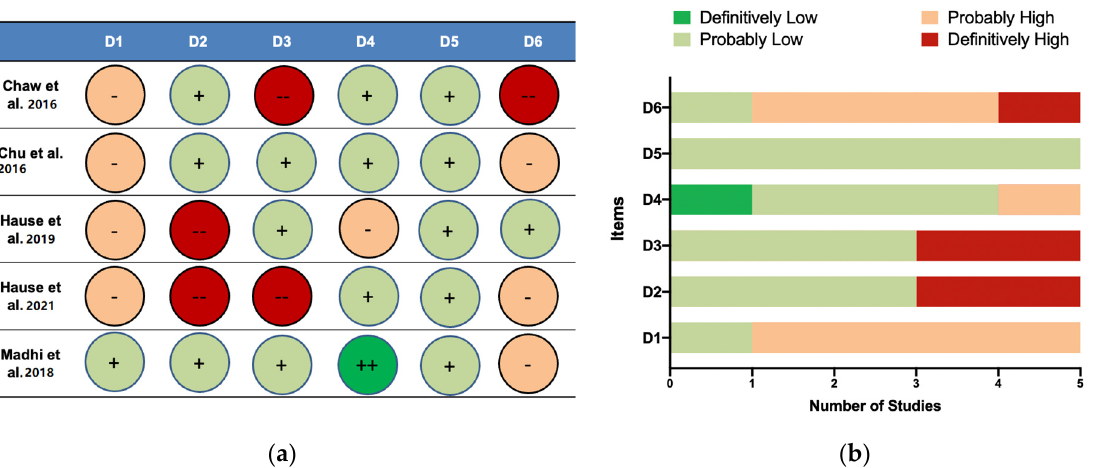
Figure 2. Summary of risk of bias assessment (Note: D1: Possibility of selection bias; D2: Exposure assessment; D3: Outcome assessment; D4: Confounding; D5: Reporting bias; D6: Other bias). ( a ) detailed report by single study [46,51–54], ( b ) summary report.